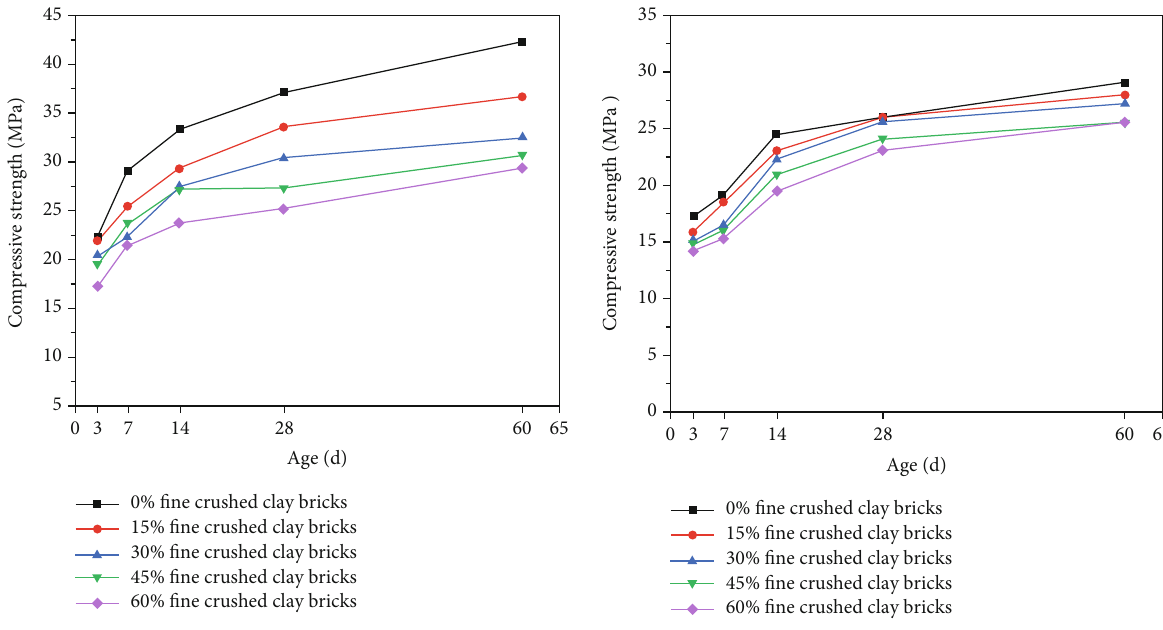
Figure 4: The compressive strength of NAC and RAC with di ff erent fi ne crushed clay brick contents.